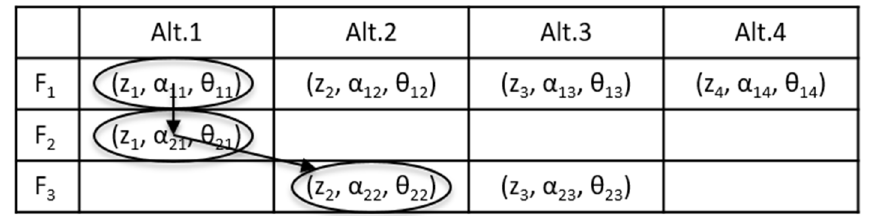
Figure 29. The matrix illustrates how to optimize the sequence to meet the criteria of minimizing measuring cycle